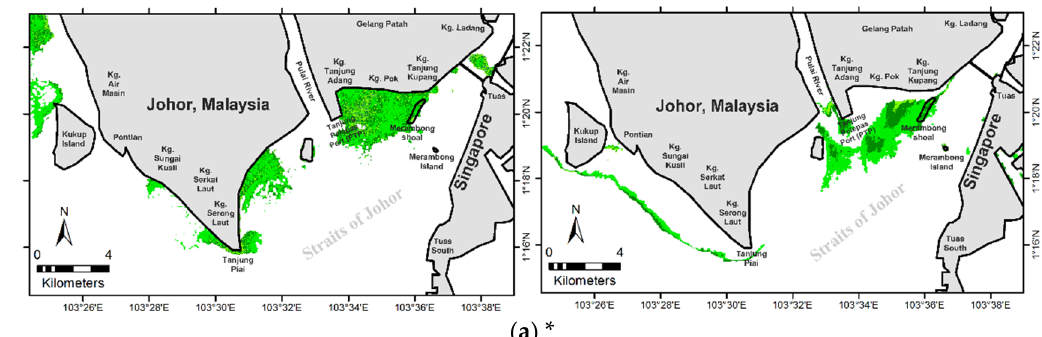
Figure 8. Cont. Figure 8.